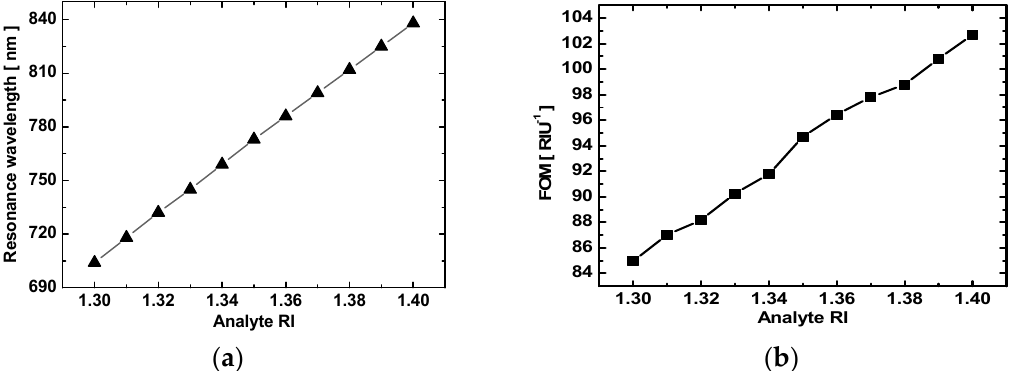
Figure 6. Sensing properties for the isosceles right-angle prism. ( a ) Resonance wavelength as a function